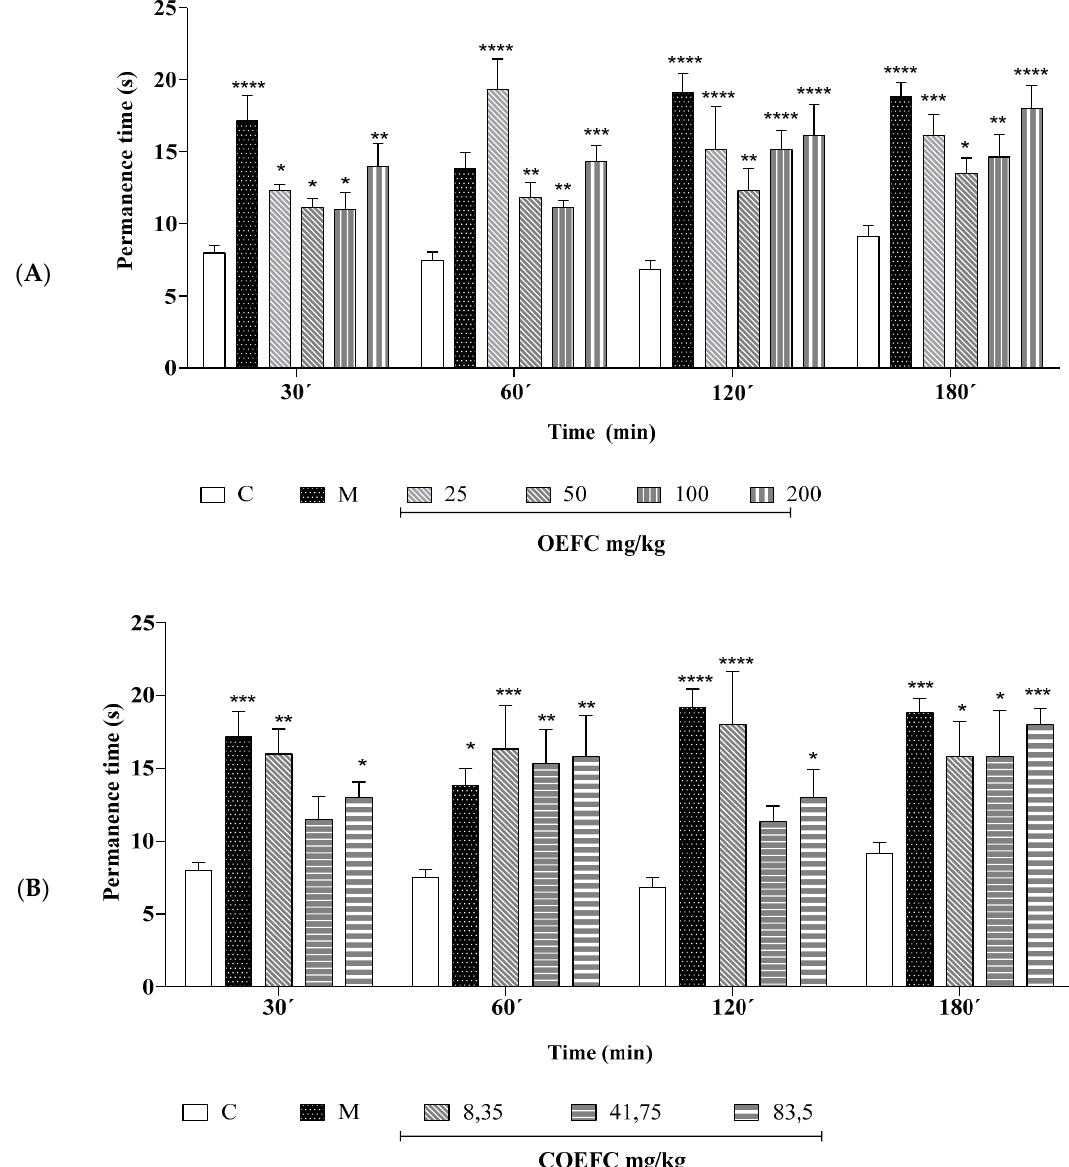
Figure 5. Effect of the OEFC (25, 50, 100, and 200 mg/kg/v.o.) ( A ) and COEFC (8.35, 41.75, and 83.5 mg/kg/v.o.) ( B ) on hot plate permanence time. The effects of the OEFC (25, 50, 100 and 200 mg/kg/v.o.) ( A ) and COEFC (8.35, 41.75 and 83.5 mg/kg/v.o.) ( B ) on Hot plate permanence time are outlined below. Groups: control-C (10 mg/kg/v.o.), morphine-M (6 mg/kg/s.c.), OEFC (25, 50, 100, and 200 mg/kg/v.o.) ( A ) and COEFC (8.35, 41.75, and 83.5 mg/kg/v.o.) ( B ). Values represent the mean ± S.E.M. ( n = 6/group), where: * p < 0.05; ** p < 0.01; *** p < 0.001; **** p < 0.0001 when compared to the control group; Statistical analysis: ANOVA followed by Dunnett’s test with multiple comparisons.